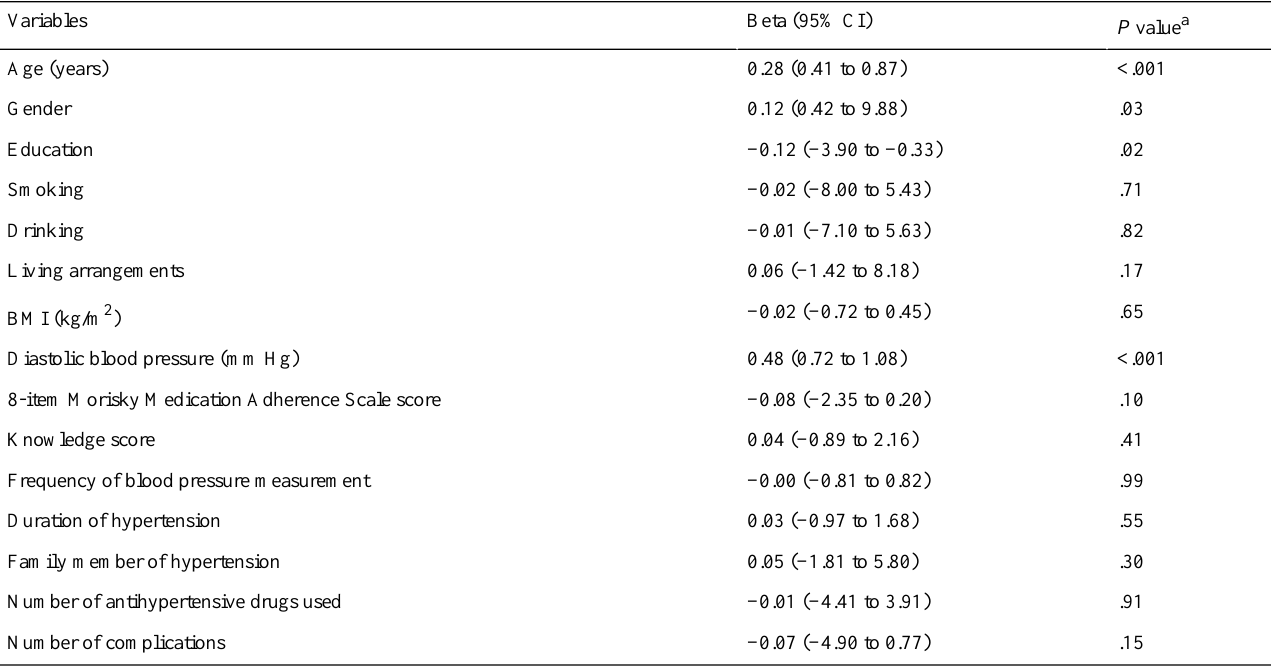
Table 4. Factors associated with systolic blood